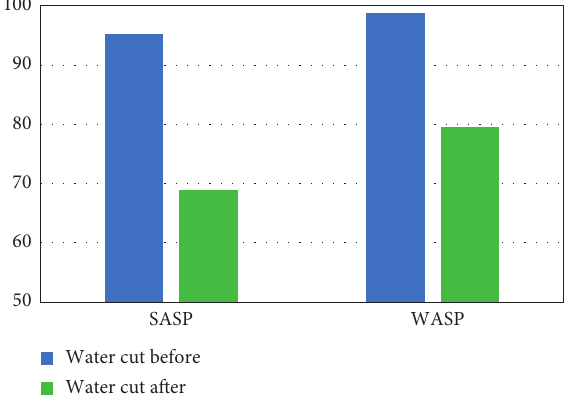
Figure 13: Water cut